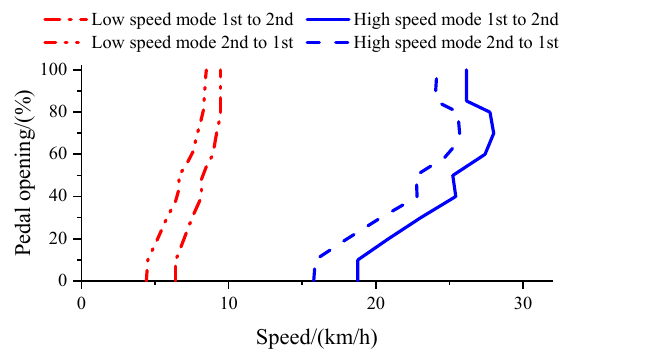
Figure 12. The comprehensive shift rule curve considering power and economy.